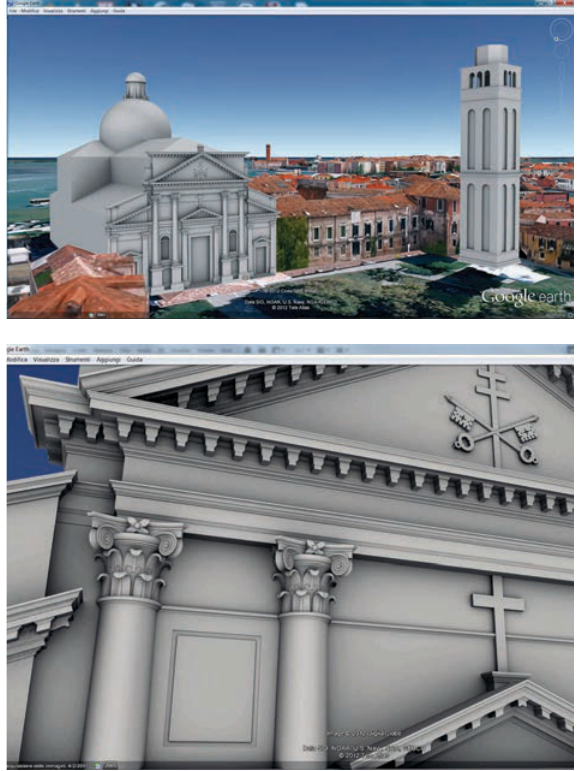
Figure 12. The church of San Pietro di Castello in GE.